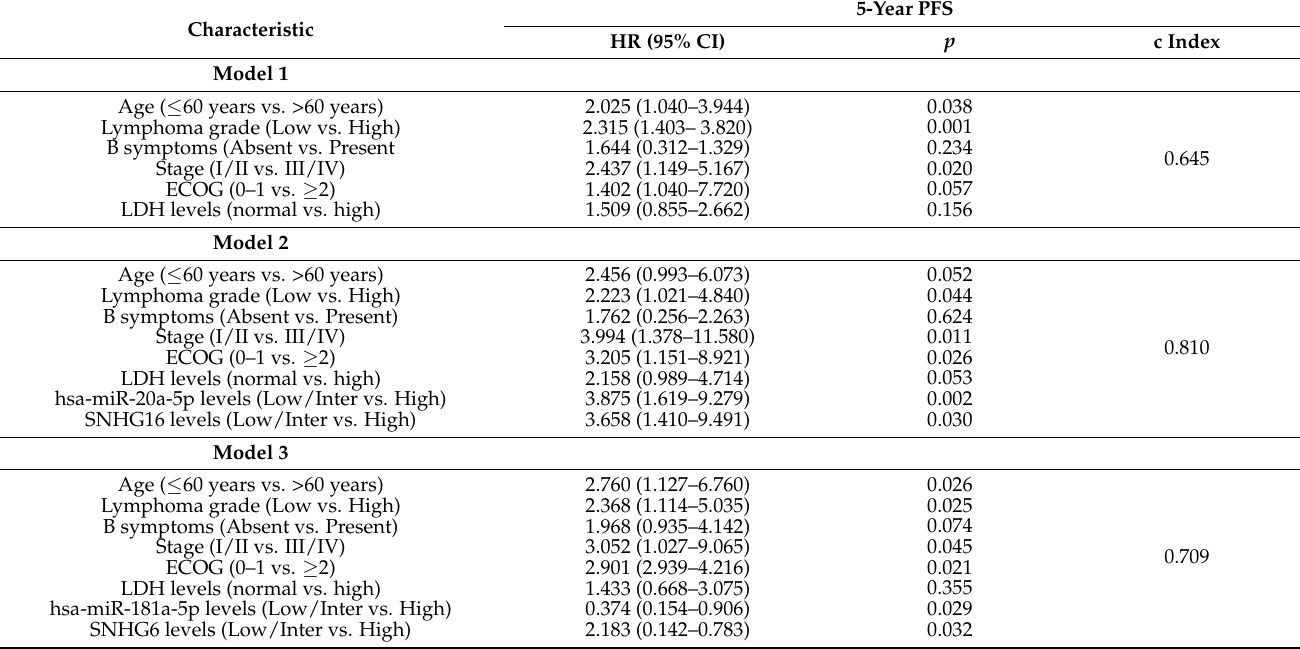
Table 6. The results of the multivariate analysis for 5-year progression-free survival for each ceRNA network